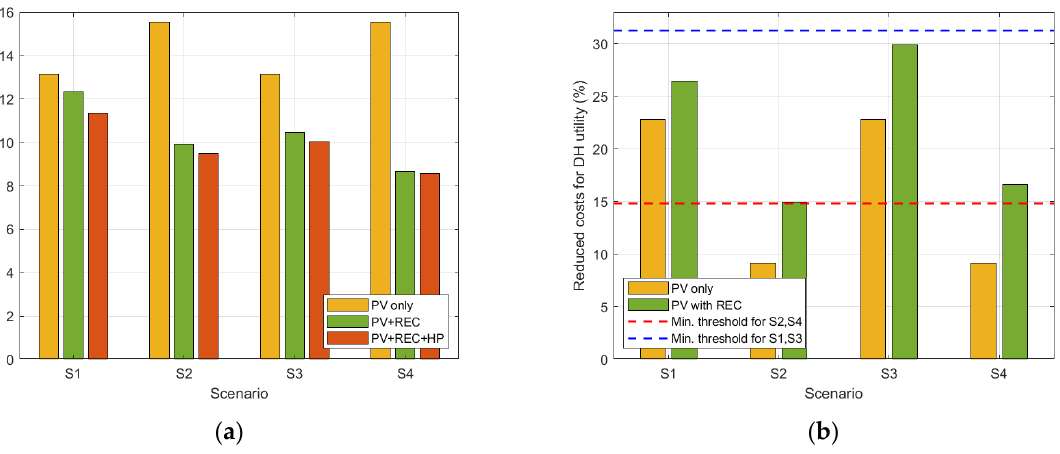
Figure 9. Effect of REC and HP on: ( a ) simple payback time for PV systems; ( b ) cost of heat and electricity supply.